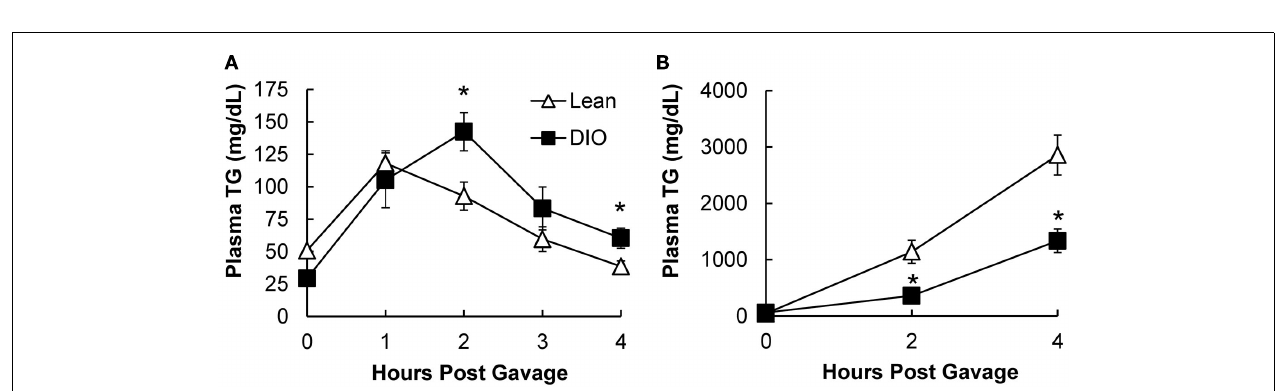
FIGURE 2 |TG storage in enterocytes of DIO and lean mice in response to dietary fat. (A) Representative CARS images ofTG storage in enterocytes of the upper jejunum of fed (2h post food removal at beginning of light cycle), baseline (6h fast), 2, 4, 6, and 8h post oil bolus in lean and DIO mice (6weeks of HF feeding). (B) TG concentration in